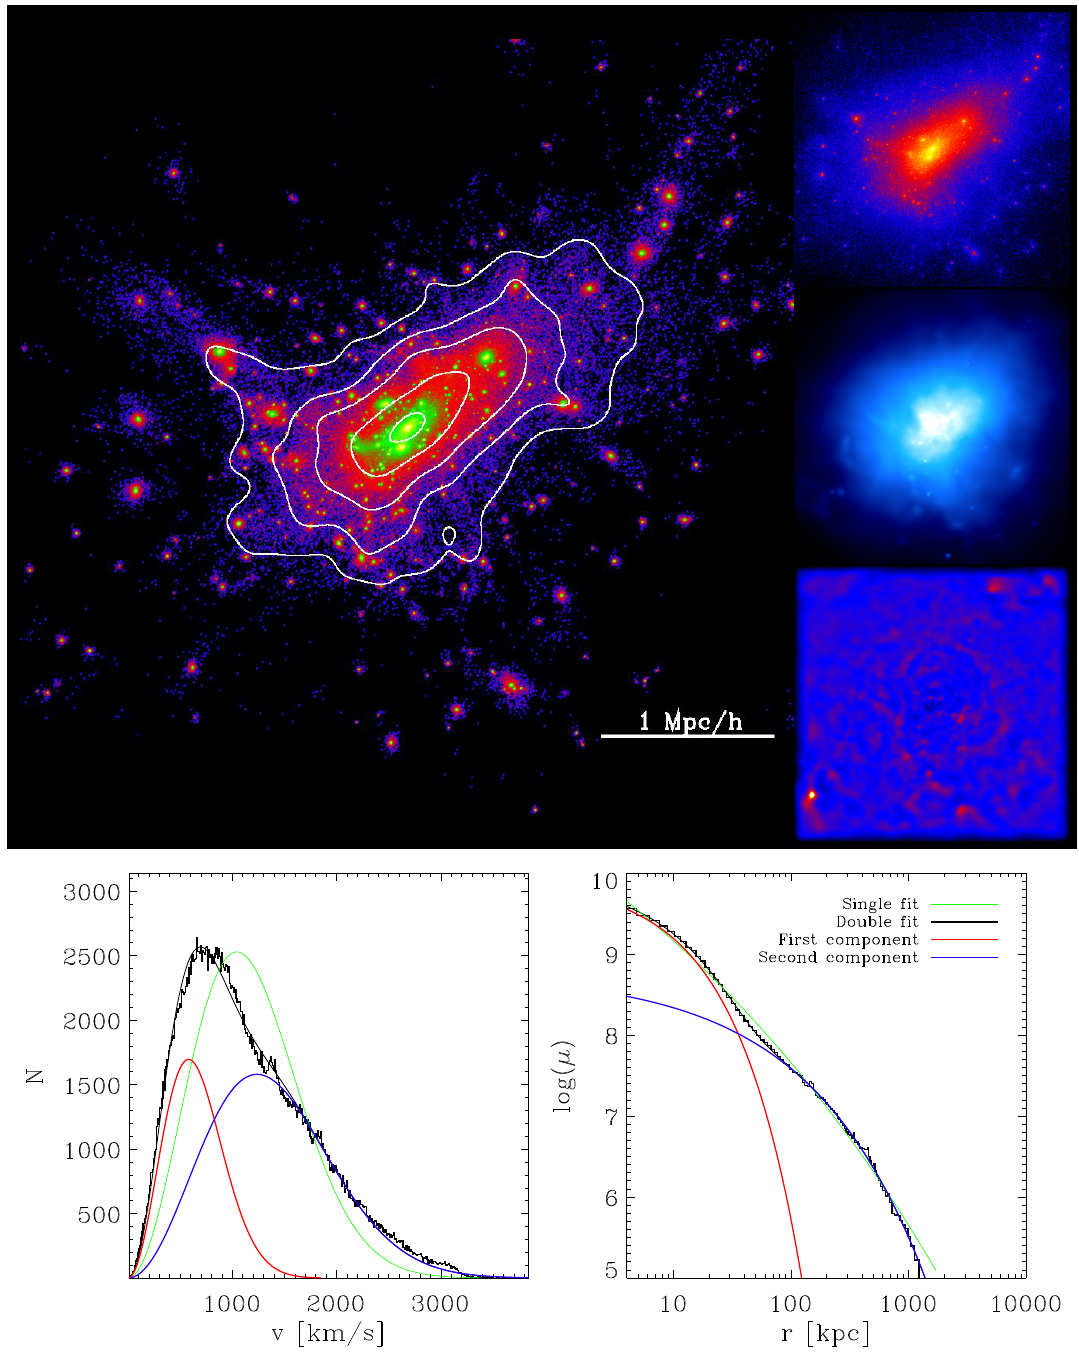
Figure 2. Same as Figure 1 but for a cluster with a double Maxwellian distribution in the velocity and a double Sérsic radial surface density profile as best representation (class d/d). Although the cluster is quite extended, there are no shocks visible, indicating a very late state of the merger. (Continued from Figure 1.) The green line shows the best single-Maxwell fit to the histogram, while the black line shows the best double-Maxwell fit to the histogram with the red and blue lines indicating the individual Maxwellians of the BCG (first) component and the DSC (second) component. Lower right panel: Projected radial stellar surface density profile (with substructures already subtracted) of the cluster centered around the BCG—colours as in the left panel but for the Sérsic